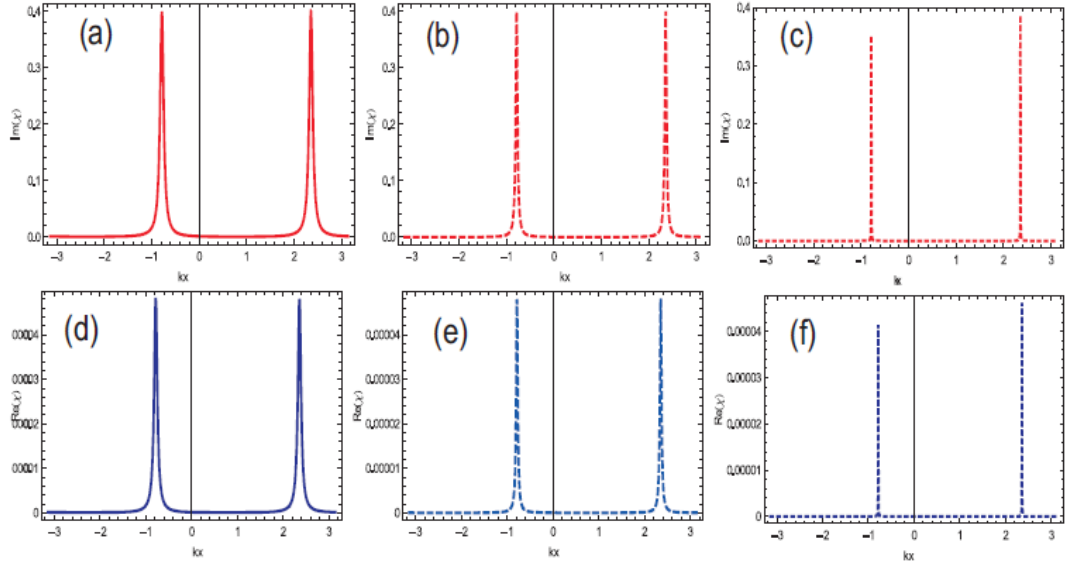
Figure 5. Localization of atom vs kx at the parameters γ = 1 GHz , | Ω 1,2,3 | = R = 50 γ [ a , d ] ,100 γ [ b , e ] ,1000 γ [ c , f ] , γ 1,2 = 1 γ , γ 3 = 0 γ , η 1,3 = 1, η 2 = − 1, ϕ = π